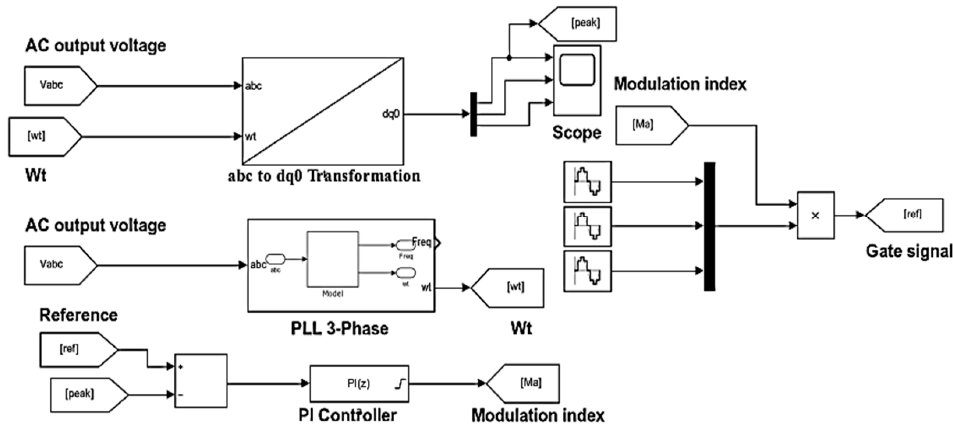
Figure 7. Diagram for the inverter-side controller.